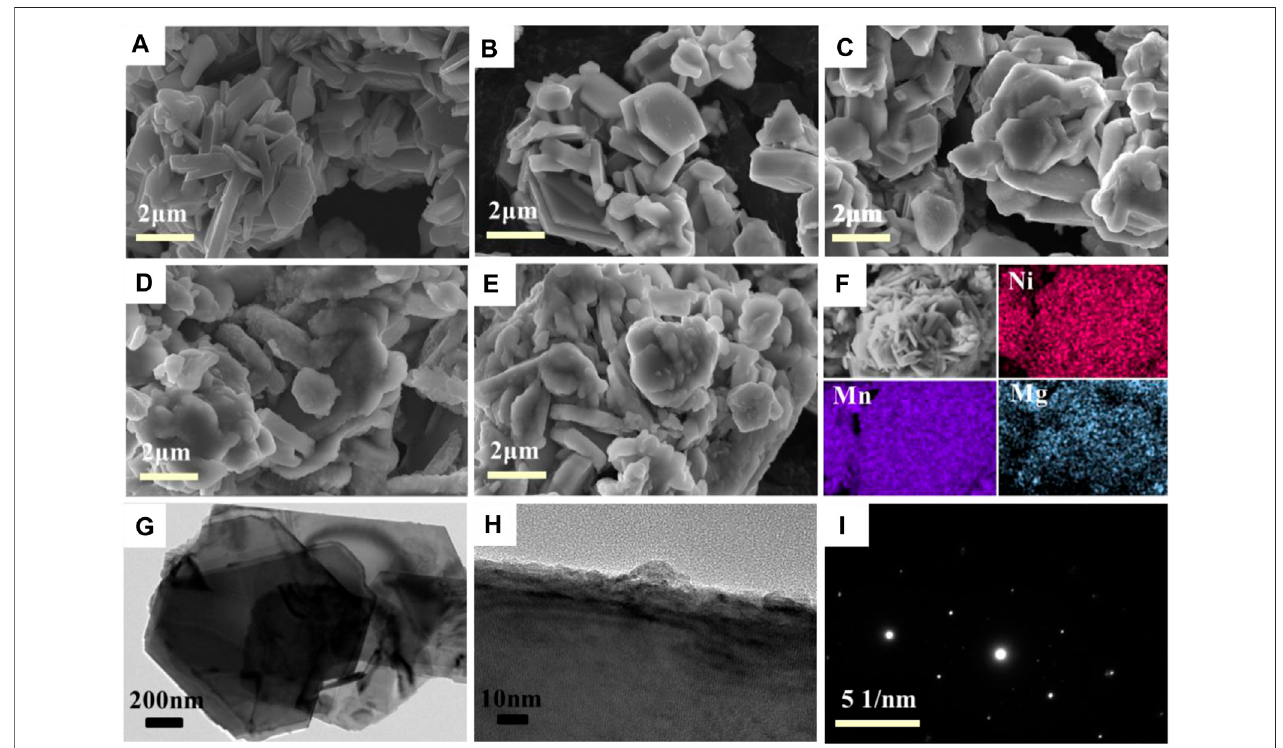
FIGURE 3 | SEM images of MgO-coated samples [ (A) 0 wt%; (B) 1 wt%; (C) 2 wt%; (D) 3 wt%; (E) 4 wt%]. (F) EDX mappings of Ni, Mn, and Mg in 2 wt% MgO- coated samples, (G) TEM image, (H) HRTEM image, and (I) SAED patters of a single particle of 2 wt% MgO-coated